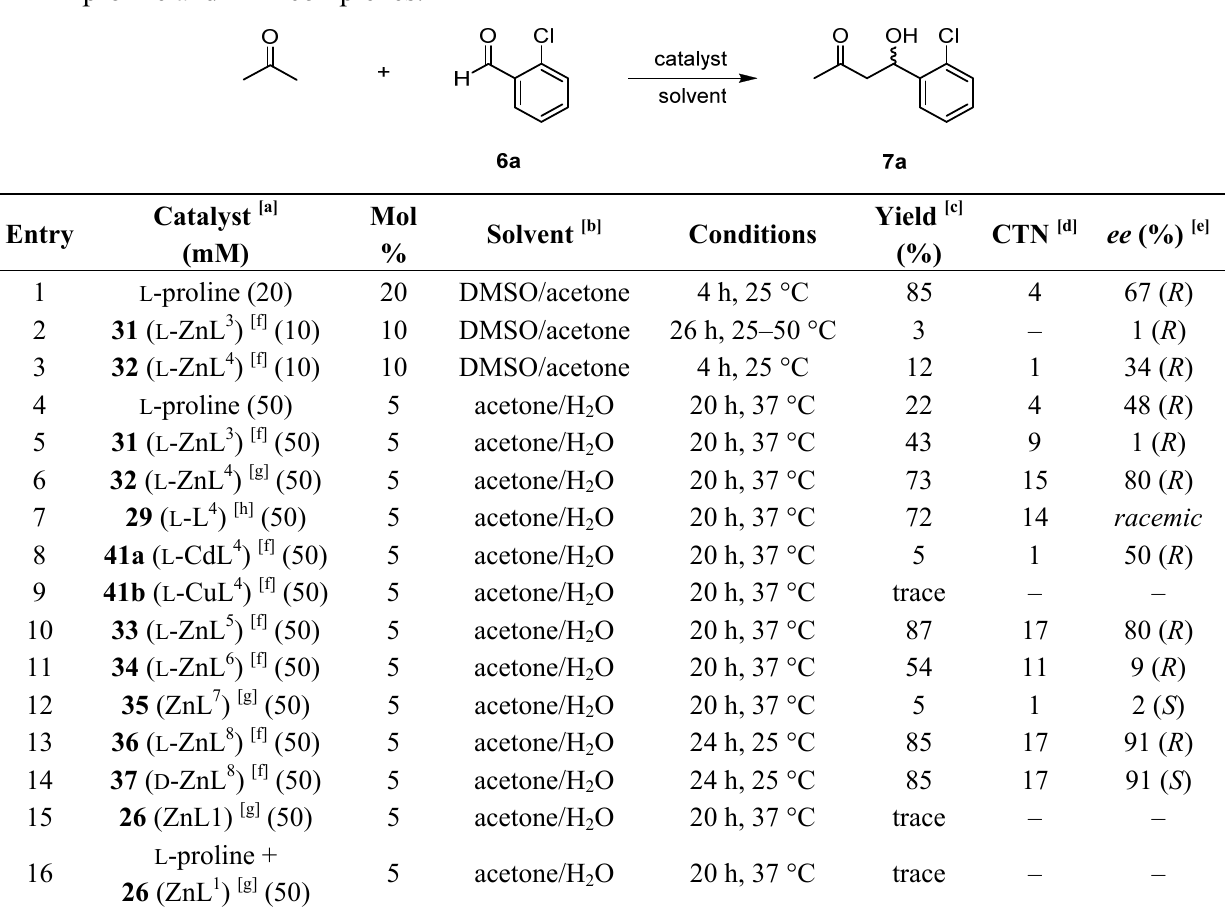
Table 1. Results for an asymmetric aldol reaction between acetone and 6a catalyzed by 2+ L -proline and Zn